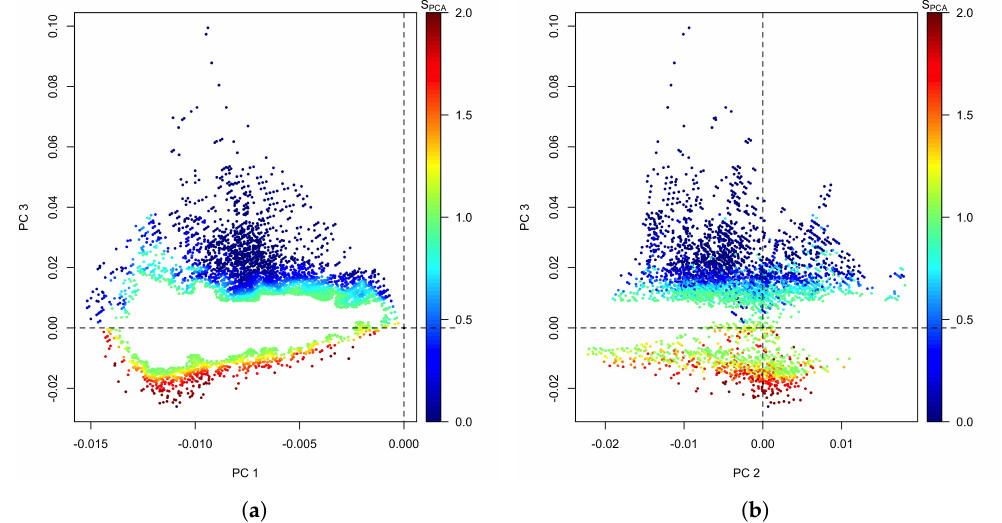
Figure 8. Principal components of subset of validation data with a performance score S PCA (cid:54) = 1; ( a ) PC 3 against PC 1 , ( b ) PC 3 against PC 2